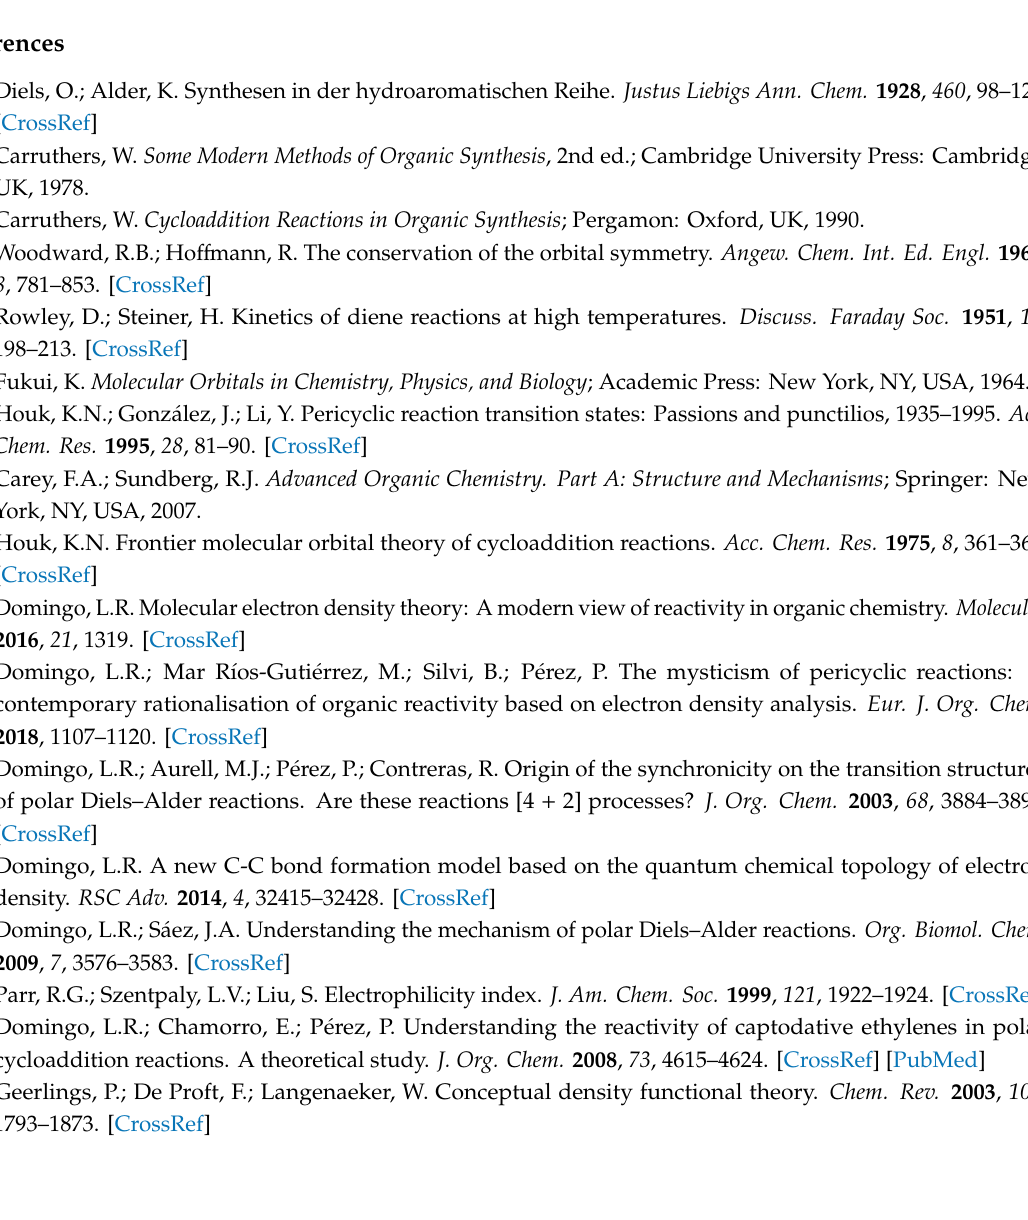
Å, Table S2 . B3LYP / 6-311G(d,p) gas phase total energies, in a.u., of the stationary points involved in the P-DA reactions between Cp 1 and acrolein 7 , and the series of LA complexes, Table S3. B3LYP / 6-311G(d,p) gas phase total energies, in a.u., of the stationary points involved in the P-DA reactions of Cps 12 – 14 with complex 7-BF 3 , Table S4. B3LYP / 6-311G(d,p) total energies, E in a.u., enthalpies, H in a.u., entropies, ∆ S in cal · mol − 1 K − 1 , and Gibbs free energies, G in a.u., computed at 25 ◦ C in DCM, of the stationary points involved in the P-DA reaction of Cp 13 with complex 7-BF 3